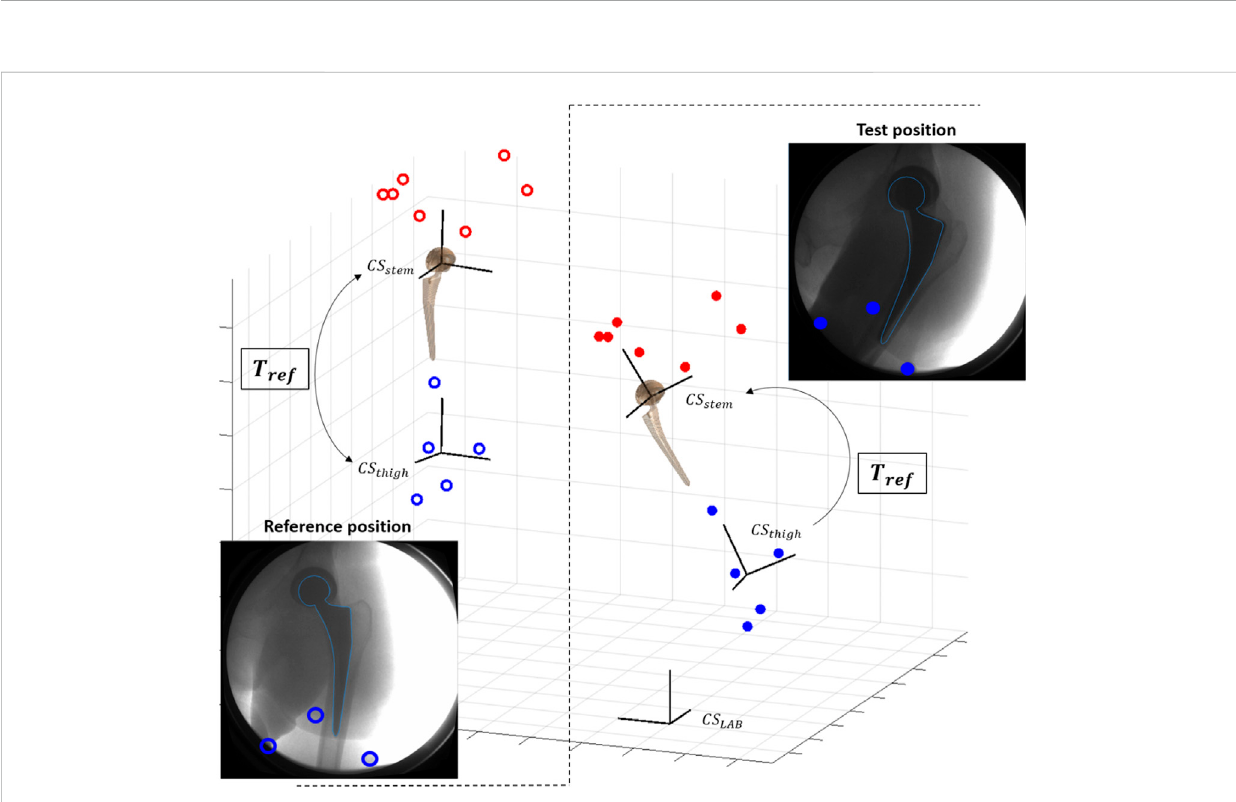
Scheme of pose initialization with skin markers (red for pelvis, blue for thigh): at reference standing position, the transformation T ref between skin- marker based segment ( CS thigh ) and prosthetic component ( CS stem ) is computed. T ref is used to initialize the pose of the prosthetic component for each new test